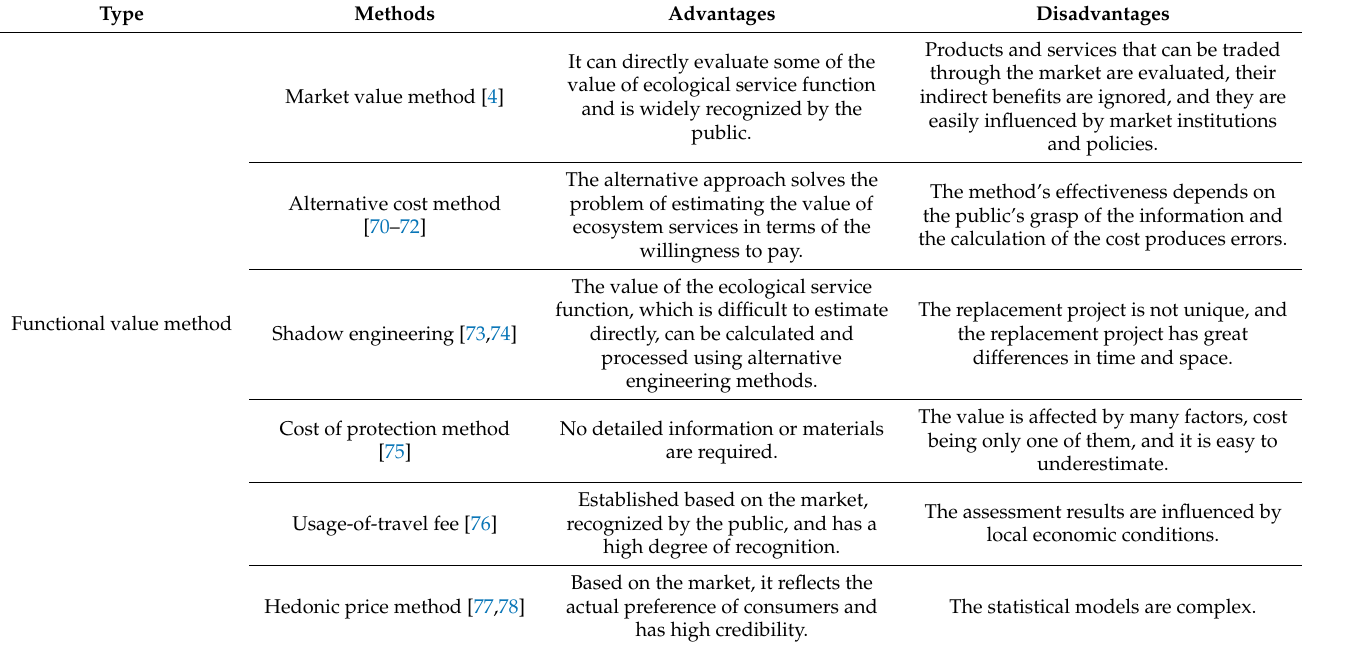
Table 2. Classification of functional value